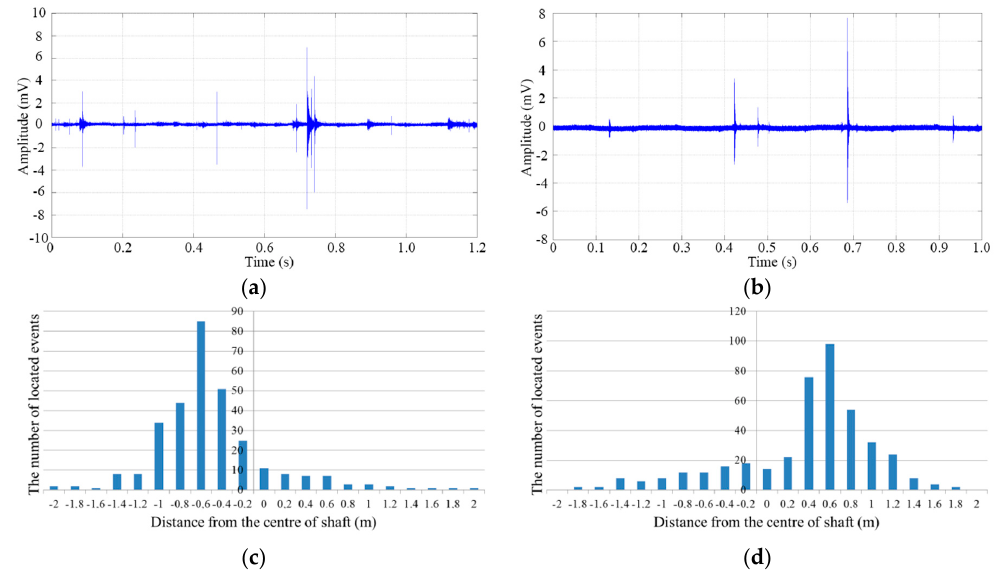
Figure 24. Waveforms of AE signals recorded on shafts of 2 roller bearings ( a , b ) and linear location results ( c , d ).